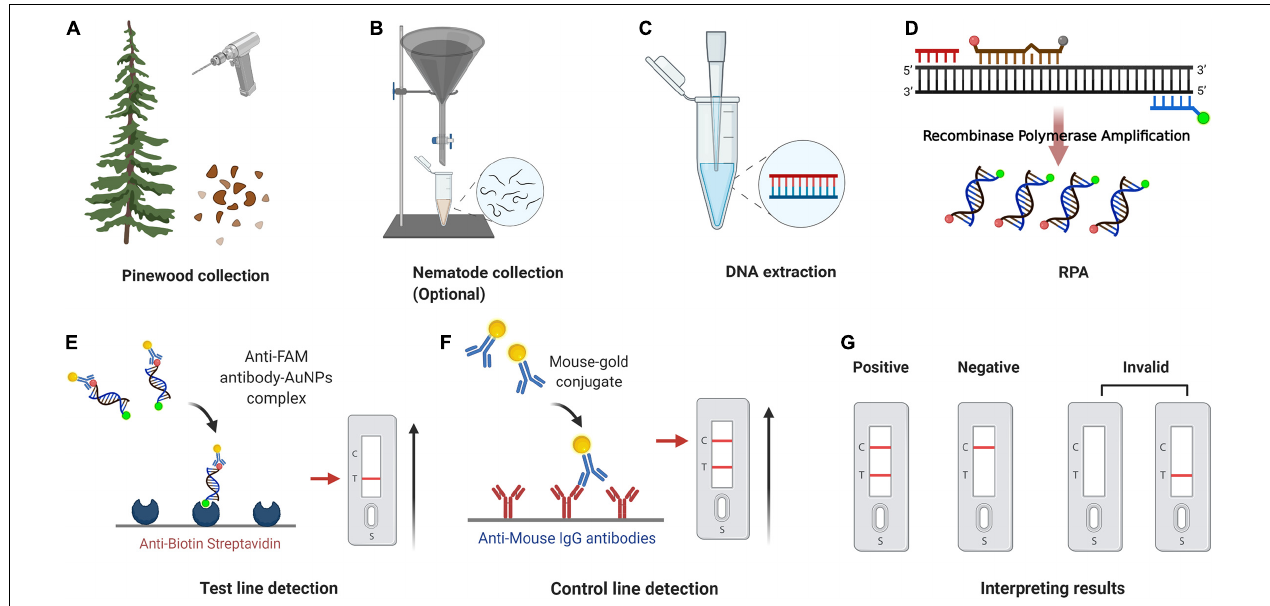
FIGURE 9 | Point-of-Care testing workflow for pinewood nematode detection. (A) Pinewood chips are collected from trees using an electric drill or axe. (B) Nematodes are collected from pinewood chips using Baermann funnel method (optional). (C) gDNA is extracted from nematode/pinewood using DAP lysis buffer. (D) Recombinase polymerase amplification. (E) The sample enters testing well (T) and anti-FAM antibody-AuNPs complex binds to immobilized anti-biotin streptavidin. (F) Mouse antibody-gold conjugate binds to immobilized anti-mouse IgG antibodies. (G) Positive result: one dipstick each in C line and T line; Negative result: one dipstick in C line; Invalid result: no dipstick in C line despite the T line. The whole procedure for the RPA-LFD assay could be finished under 38 ◦ C within about 30 min, including 15 min for nematode gDNA extraction and master mix preparation, 15 min for the RPA-LFD assay (10 min for RPA reaction, 5 min for visual detection on the LFDs). Adapted from “COVID-19 Serologic Diagnostic Test through Antibody Detection,” by BioRender.com (2020). Retrieved from https://app.biorender.com/biorender-templates.